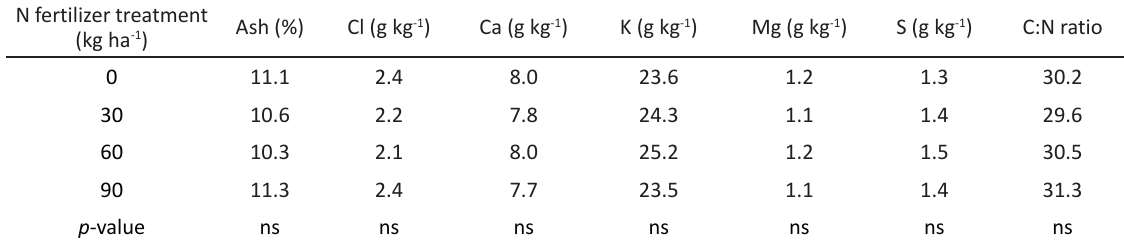
Table 5. Ash content and mineral element composition of Jerusalem artichoke grown at four N fertilizer rates rates during two growing seasons (2010 and 2011) in Helsinki, Finland. Data shown are means, n = 8. N fertilizer treatment (kg ha -1